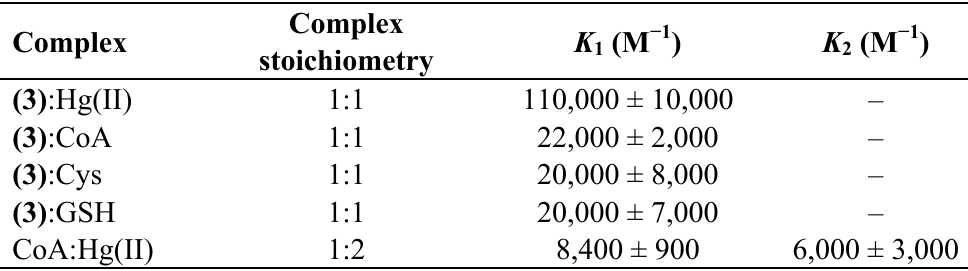
Table 1. Stability constants corresponding to the complex (3):X [X = Hg(II), CoA, Cys and GSH], and CoA:Hg(II).